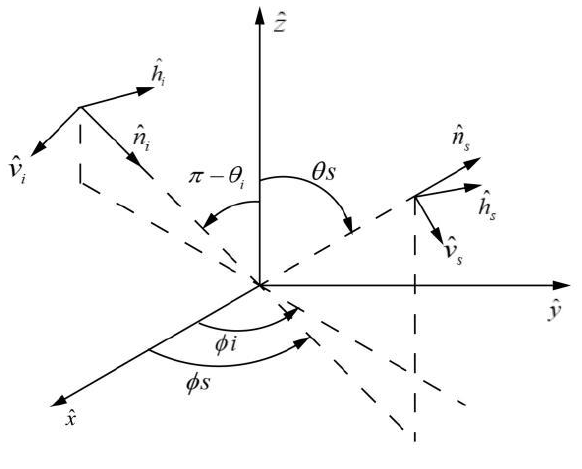
Figure 1. Forward scatter alignment. Vertical and horizontal vectors in FSA are defined along the direction of wave propa- gation. The coordinate system is consistent with the standard spherical coordinate